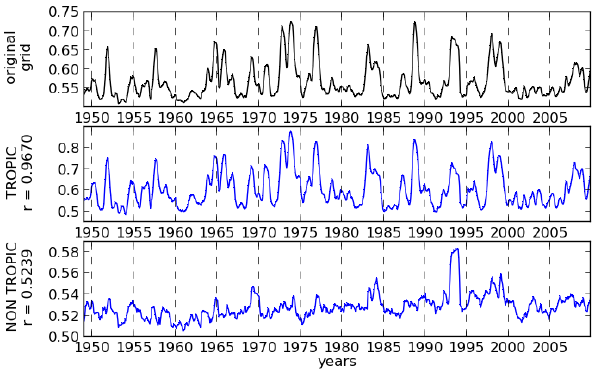
Fig. 9. The temporal evolution of the tropical and extra-tropical 8 subgraph.